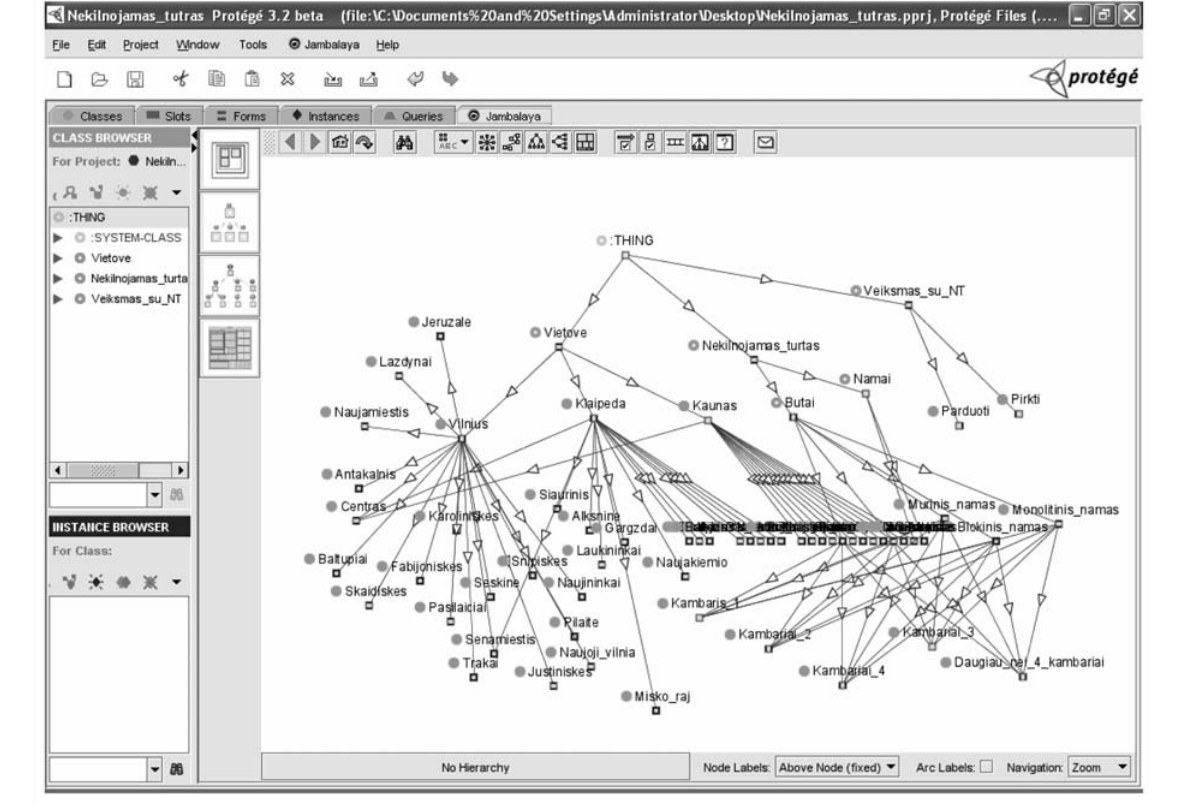
Fig 3. Application of Protégé 3.2. software for the realty ontology